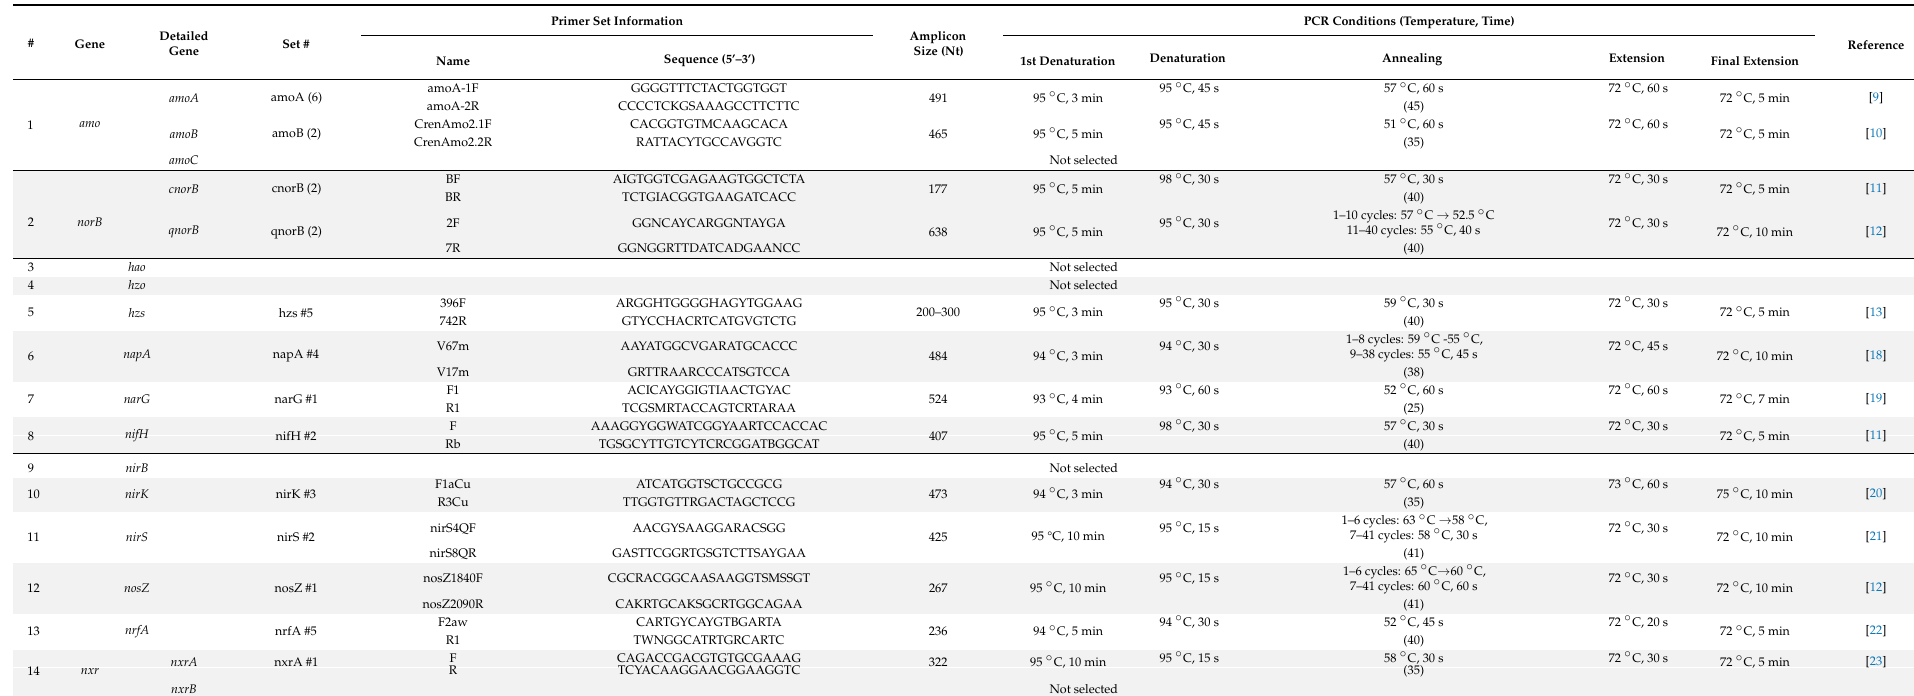
Table 2. Description of selected PCR primer sets for functional gene monitoring related to the nitrogen cycle in surface